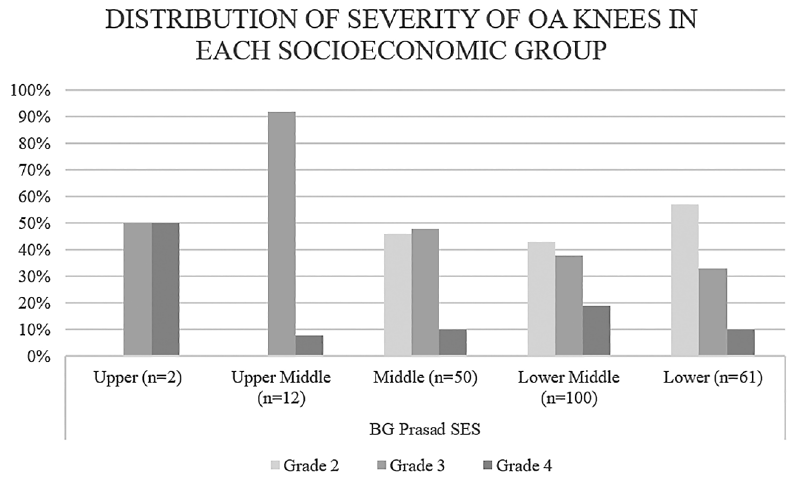
Figure 2. Distribution of knee osteoarthritis (OA) severity by socioeconomic group. Higher socioeconomic groups had a higher proportion of patients with severe grade knee